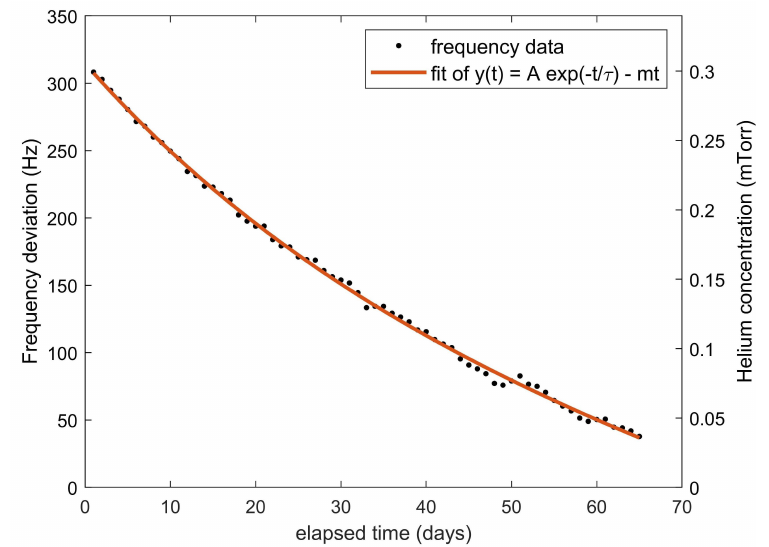
Figure 2. Daily average frequency data over time (dots), along with an exponential decay fitting function (red line) that also includes a small linear drift. The data and fit are manually offset so that they gradually approach y = 0, which corresponds to a helium-free condition. The observed time constant T cell is 38(10) days. The right y axis displays the inferred remaining partial pressure of helium in